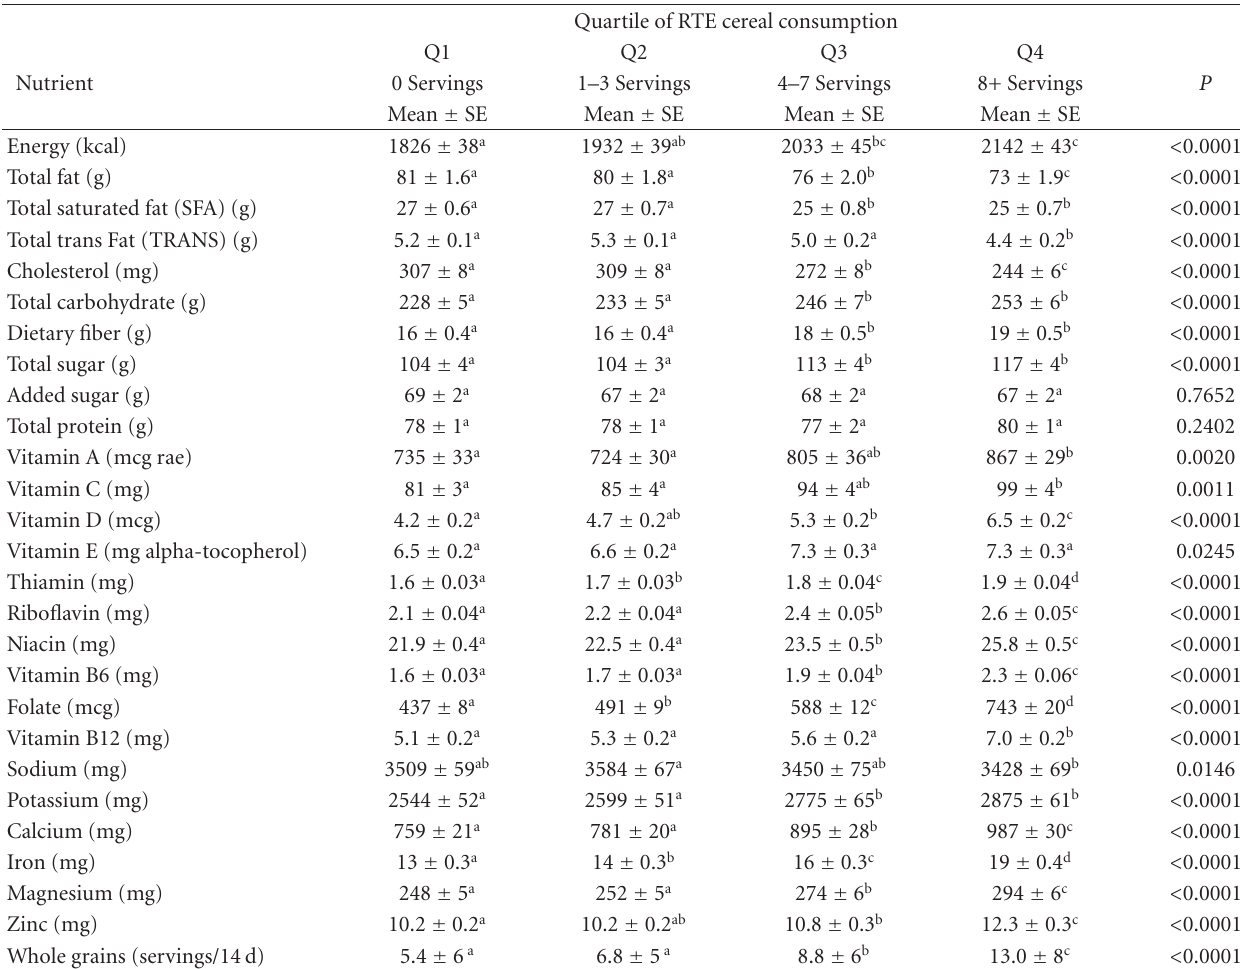
Table 2: Adjusted ∗ mean daily nutrient intake for adult men, ages 55+, by quartile of cereal